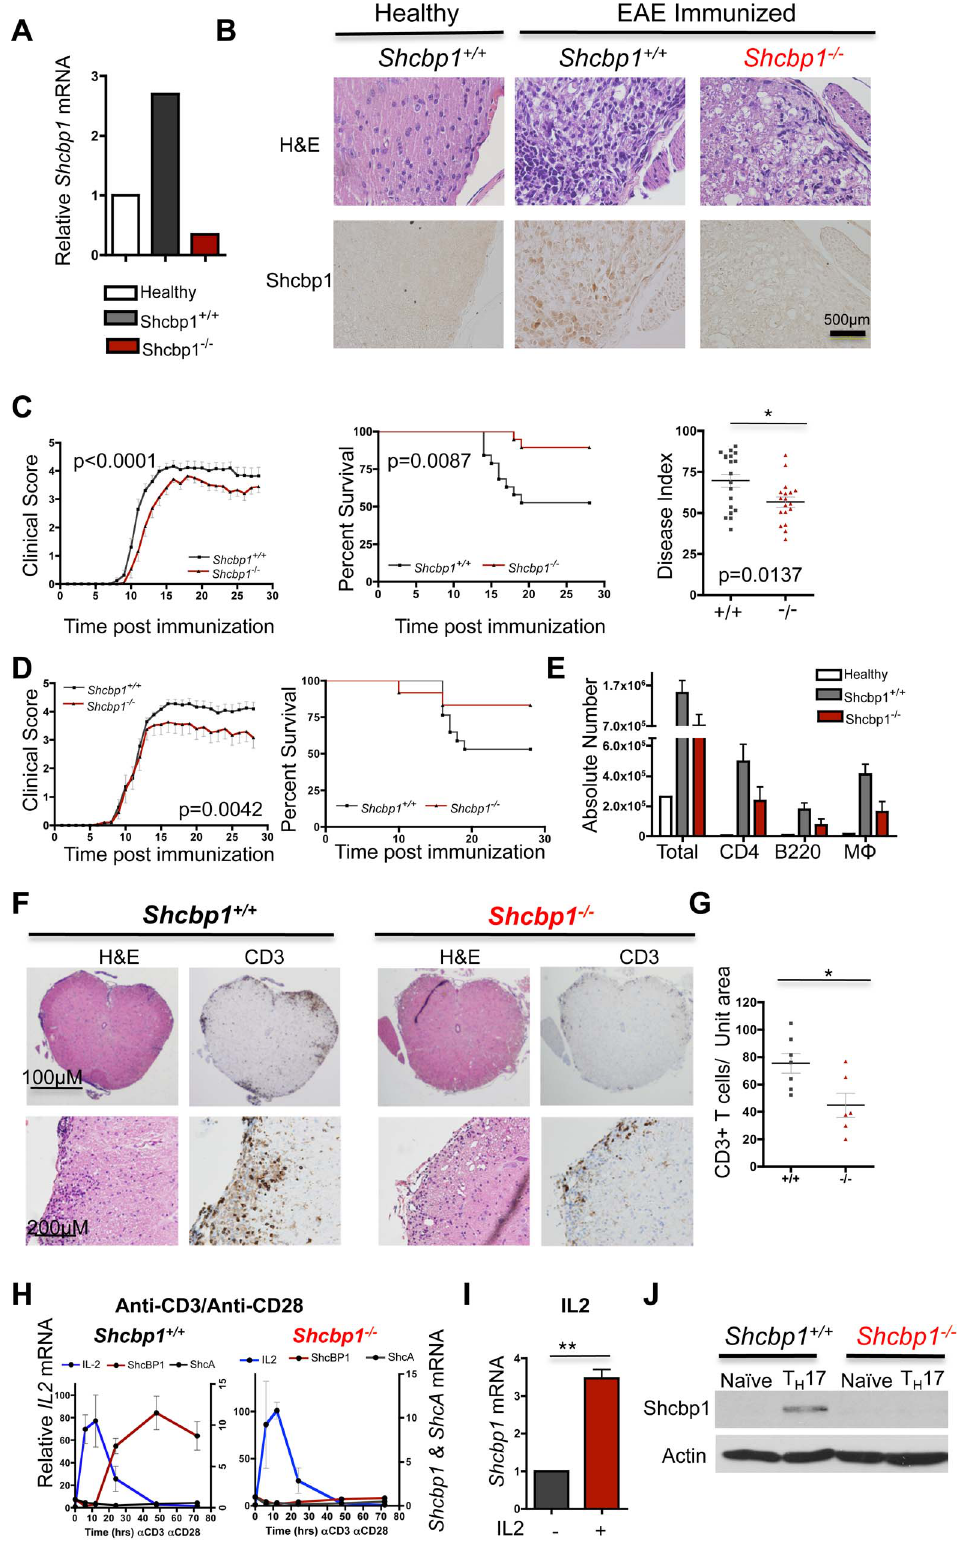
Figure 6. Loss of Shcbp1 affects disease severity in CD4 + T cell driven autoimmune disease. (A) Shcbp1 mRNA expression in mononuclear cells isolated from the brain and spinal cords of healthy controls or from mice immunized with MOG (35–55) on day 28 after disease induction (Normalized to HPRT and healthy controls) (n=3 mice of each condition, pooled). (B) Shcbp1 expression assessed by immunohistochemistry in spinal cords isolated from healthy controls or Shcbp1 + / + and Shcbp1 2 / 2 mice on day 28 after immunization for EAE (n=3 mice of each condition). (C) Left,